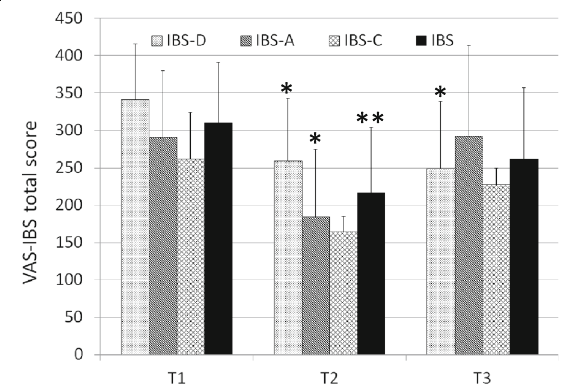
Fig. 2 Total score of the Visual Analogue Scale for Irritable Bowel Syndrome (VAS-IBS) questionnaire administered at T1, T2 and T3. Data for the whole IBS cohort and for IBS subtypes are expressed as mean ± SD. * P < 0.05 if compared to T1; ** P < 0.01 if compared to T1 (Student ’ s T